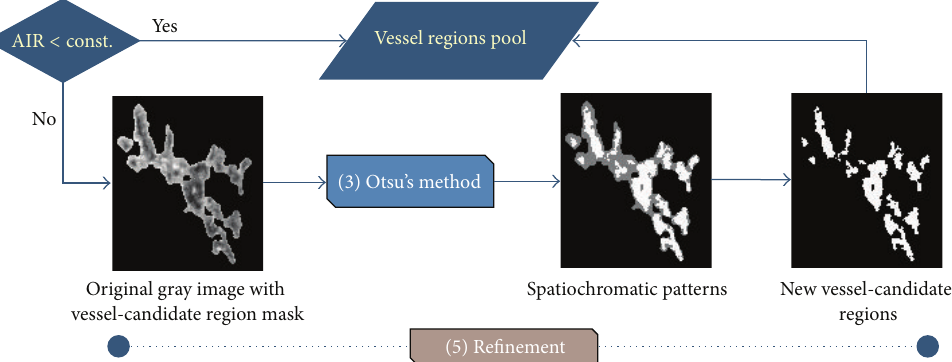
Figure 5: Refinement step process in the segmentation algorithm.